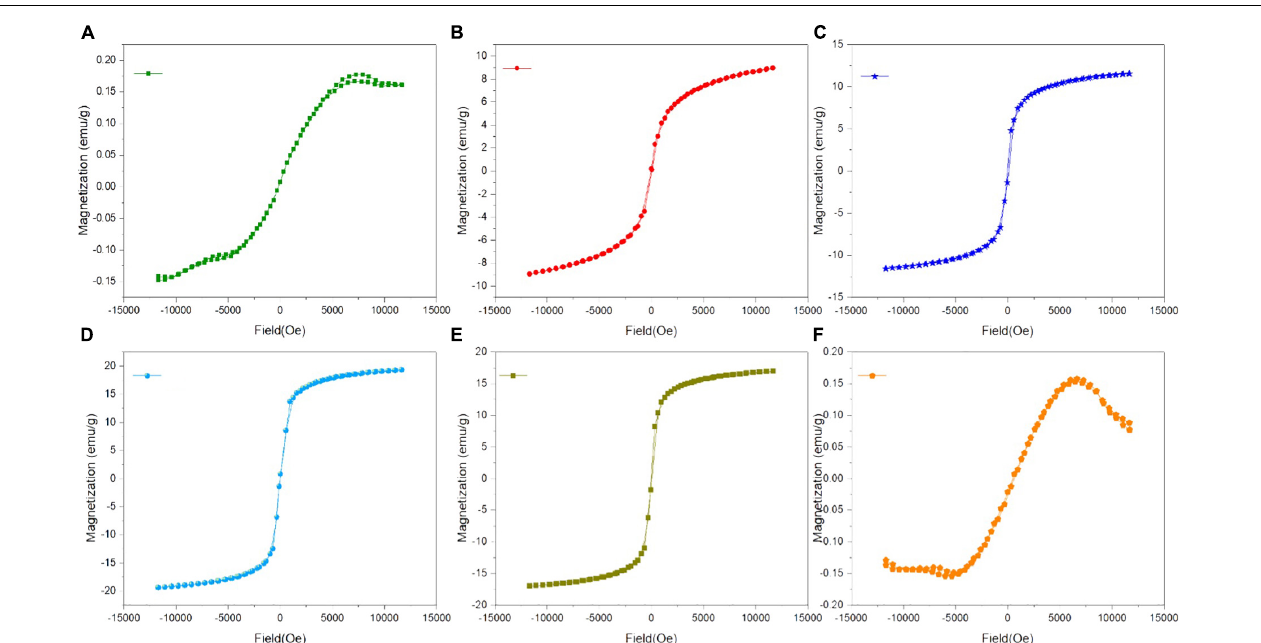
FIGURE 7 | M-H loops of green-synthesized IONPs by using extracts (A) PJ, (B) WV, (C) PP, (D) BC, (E) AP, and (F) As.